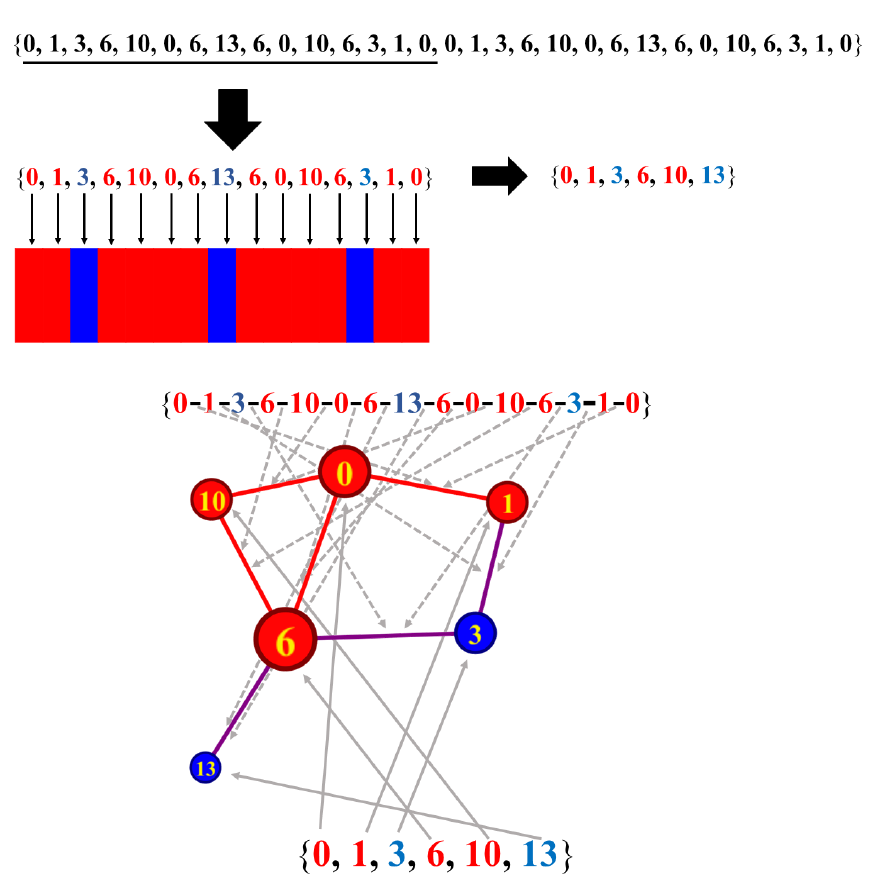
Figure 6. The example of a graph construction from T 15 for the case of m = 15. The top sequence of numbers is T 15 . By Theorem 1, this reduces to the sequence of red and blue numbers on the second line. The red numbers indicate the perfect squares for m = 15 and the blue represent the nonsquares. The right pointing arrow indicates the further reduction to the set of unique triangular numbers modulo 15. The sequence can then be represented by the block graph of red and blue segments, or as a (network) graph (called G 15 ). This is discussed in Section 8.3. The set of unique triangular numbers modulo 15 is the set of vertices (identified with solid gray arrows), and the pathway through the sequence is the set of edges (identified with dashed gray arrows). Red vertices (edges) indicate perfect squares (a connection between a pair of perfect squares). It is the same for blue but for nonsquares. The purple edges indicate a connection between a perfect square and a